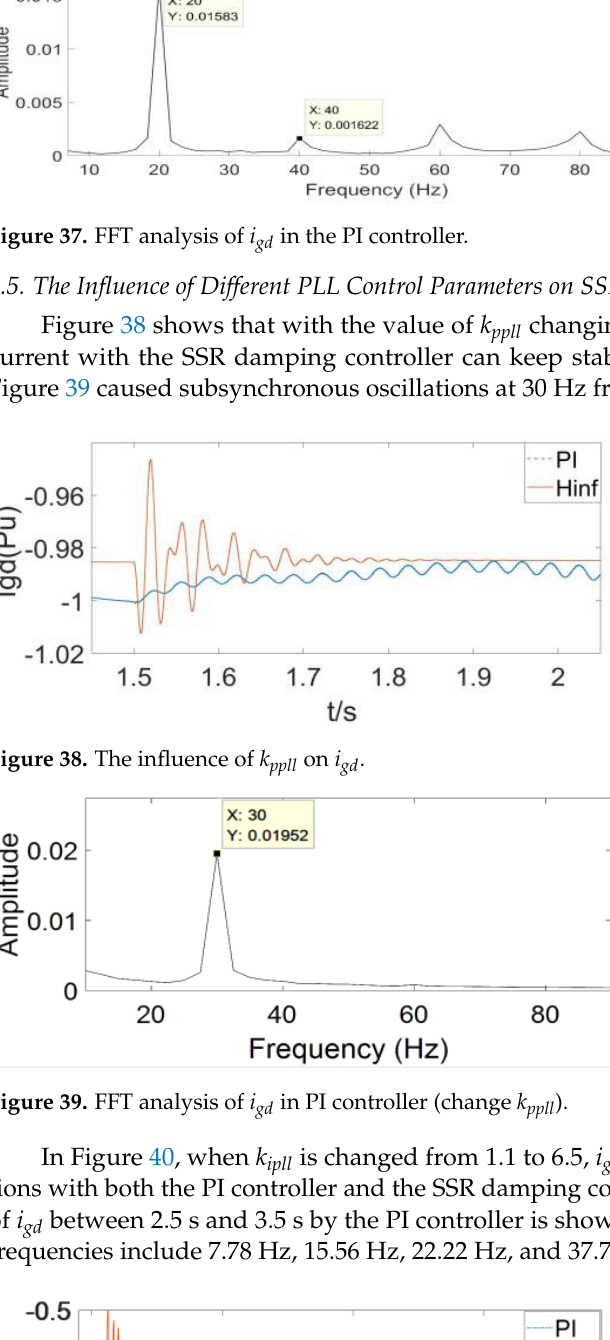
Figure 40. The influence of k ipll on i gd . Figure 41. FFT analysis of i gd in PI controller (change k ipll ). 6. Conclusions In order to solve the problem of SSR of a grid-connected direct-drive wind farm, this paper considered the uncertainties of various factors in the system, analyzed the influenc- ing factors of SSR, and designed a H ∞ damping filter controller, which aims at improving